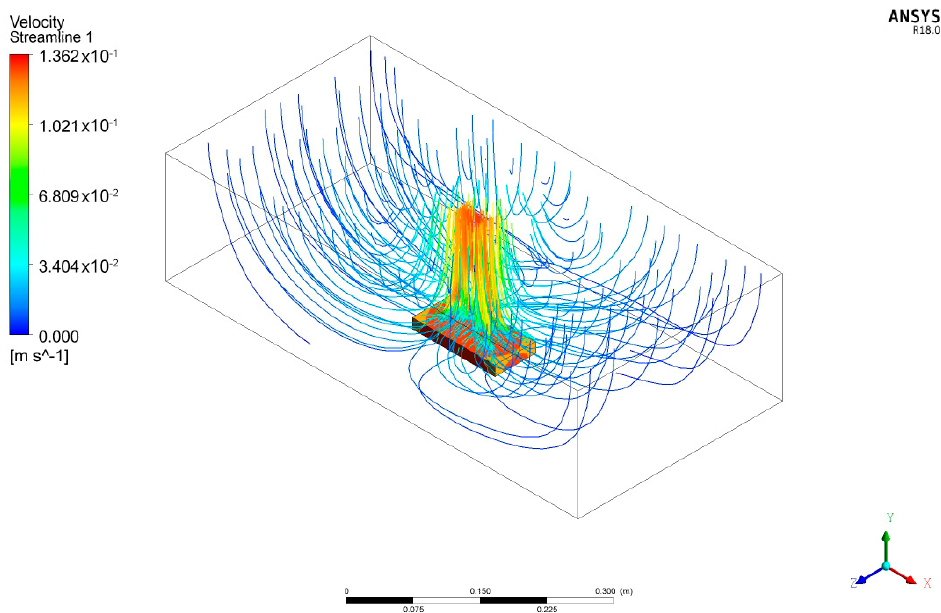
Figure 3. Streamline of air velocity.